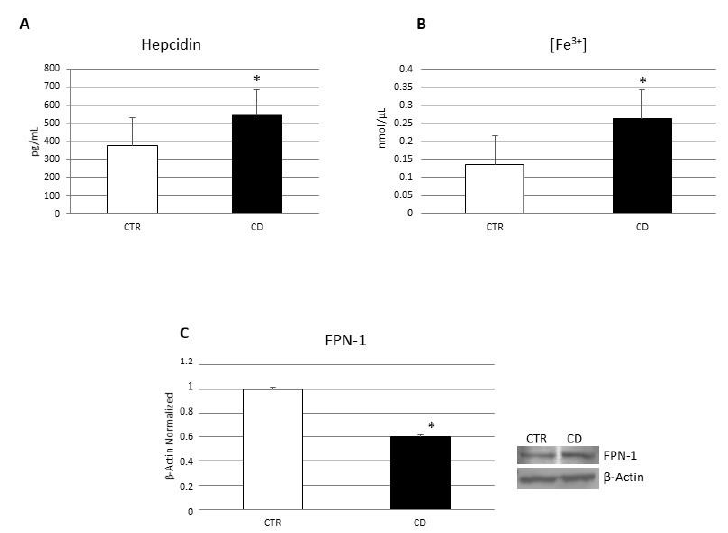
Figure 3. Iron metabolism evaluation in CD macrophages. ( A ) Hepcidin concentrations (pg/mL) in macrophages from 5 CD patients compared with macrophages from 5 CTR, determined by ELISA Assay. Histogram shows Hepcidin concentration as the mean ± S.D of independent experiments on each individual sample. The cytokine concentration was determined on a standard concentration curve according to the manufacturer’s instructions. ( B ) Fe3+ intracellular concentrations (nmol/ µ L) in macrophages from 5 CD patients compared with macrophages from 5 CTR determined by Iron Assay. Histogram shows Fe3+ concentration as the mean ± SD of independent experiments on each individual sample. ( C ) Ferroportin (FPN-1) protein levels, determined by Western Blot, loading 15 µ g of total lysate, in macrophages from 5 celiac disease (CD) patients compared with macrophages from 5 healthy donors (CTR). The most representative images are displayed. Image Studio Digits software has been used to detect protein bands. The intensity ratios of immunoblots compared to CTR, considered 1, were quantified after normalizing with respective controls. The histograms represent the relative quantification for FPN-1 expression, normalized for the housekeeping protein β -Actin, as mean ± SD of independent experiments on each individual sample. A t -test has been used for statistical analysis. * Indicates p ≤ 0.05 compared to CTR.